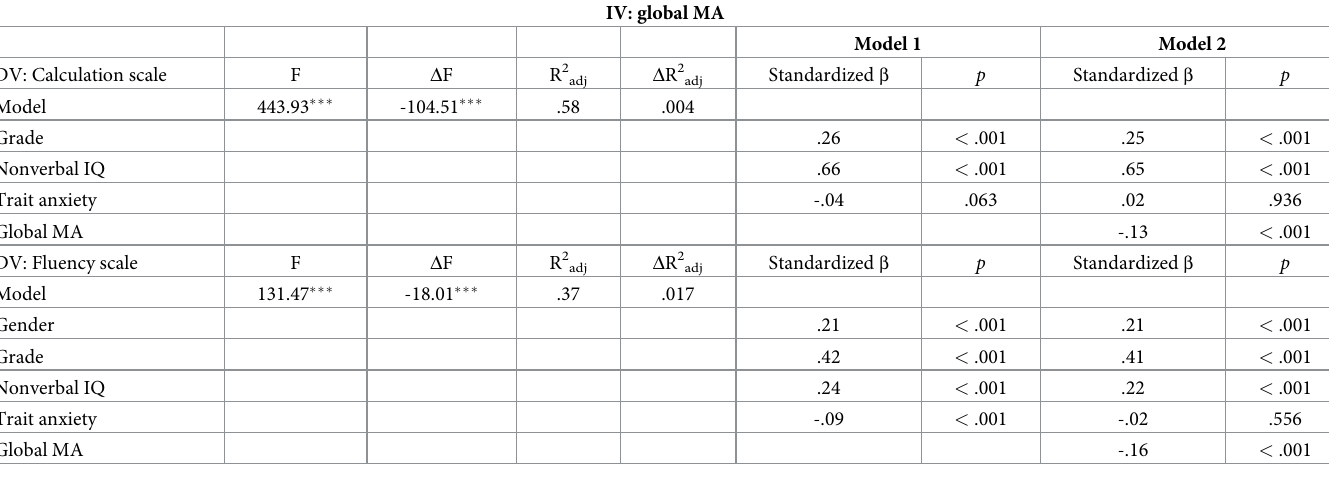
Table 5. Hierarchical regressions predicting WJ-III scale scores with global MA as an independent variable.